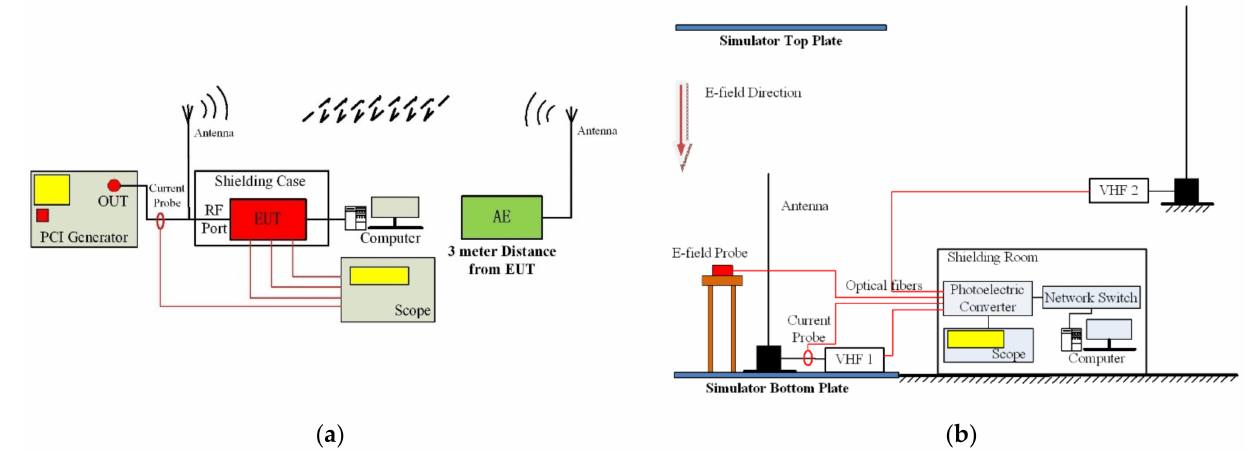
Figure 2. Test configuration of SUT: ( a ) PCI test; ( b ) pulse illumination